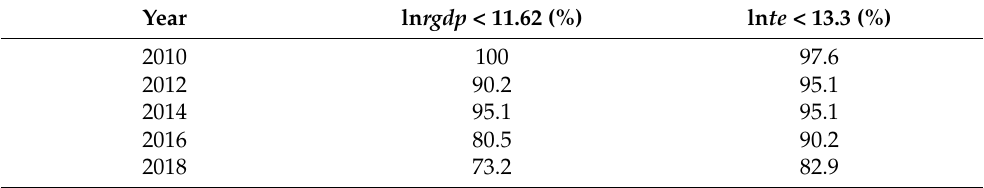
Table 6. Proportion of cities with less than threshold estimates in the Yangtze River Delta